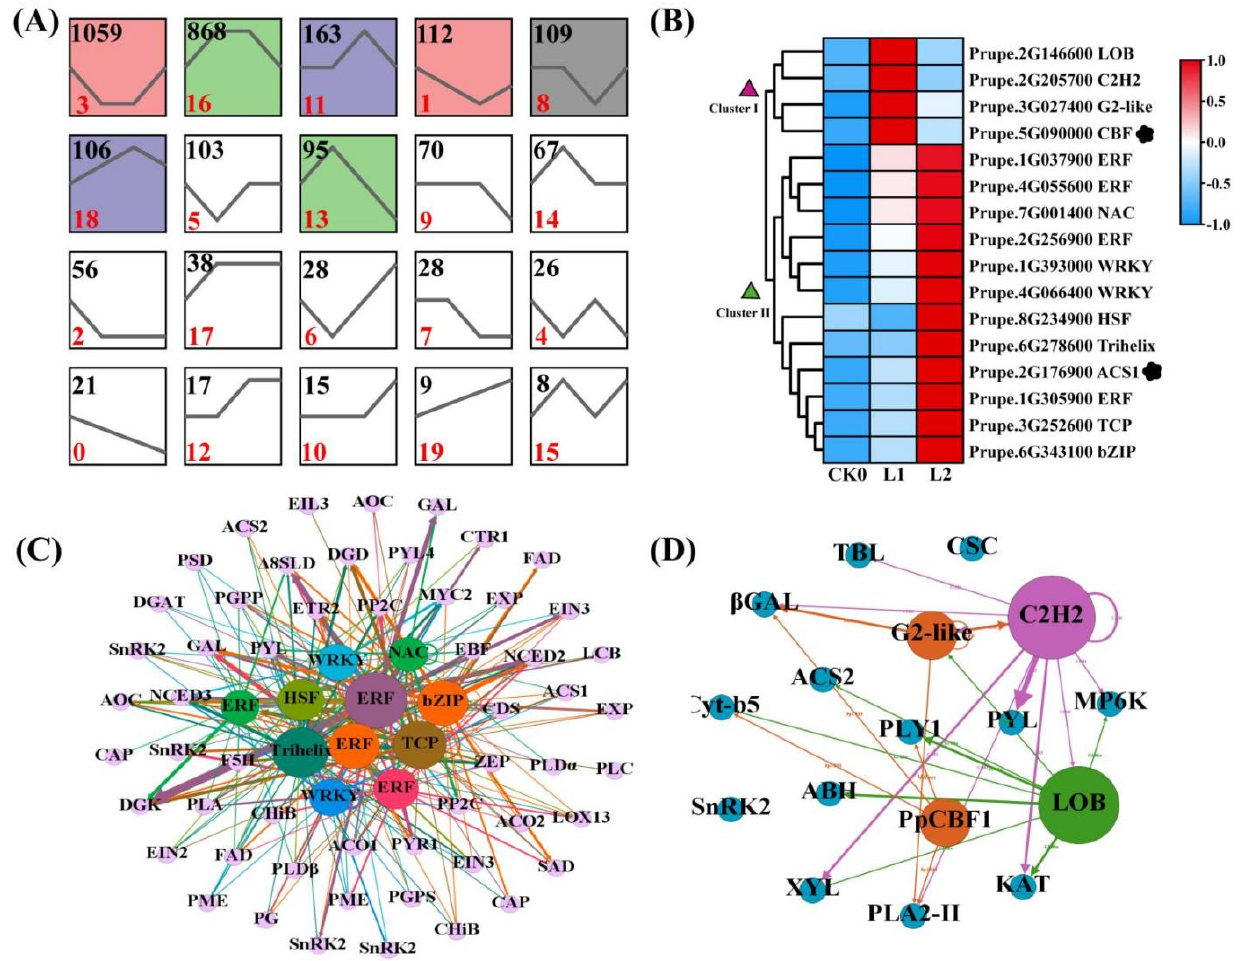
Figure 7. ( A ) Clustering of gene expression data. Expression profiles are based on the cluster of genes differentially expressed at low temperatures. Clusters with colored backgrounds have statistically more assigned DEGs than the number expected. The black line in each box represents the extracted expression pattern for each cluster; ( B ) Heatmap of differentially expressed transcription factor (TF) family members, as well as ACS1 and PpCBF1 genes during SH peach fruit cold storage; ( C ) Co-expression network comprising cluster Ⅱ TFs and genes related to cell wall modification, lipid metabolism, and phytohormone biosynthesi s ; ( D ) Co-expression network comprising cluster Ⅰ TFs and genes related to cell wall modification, lipid metabolism, and phytohormone biosynthesis.